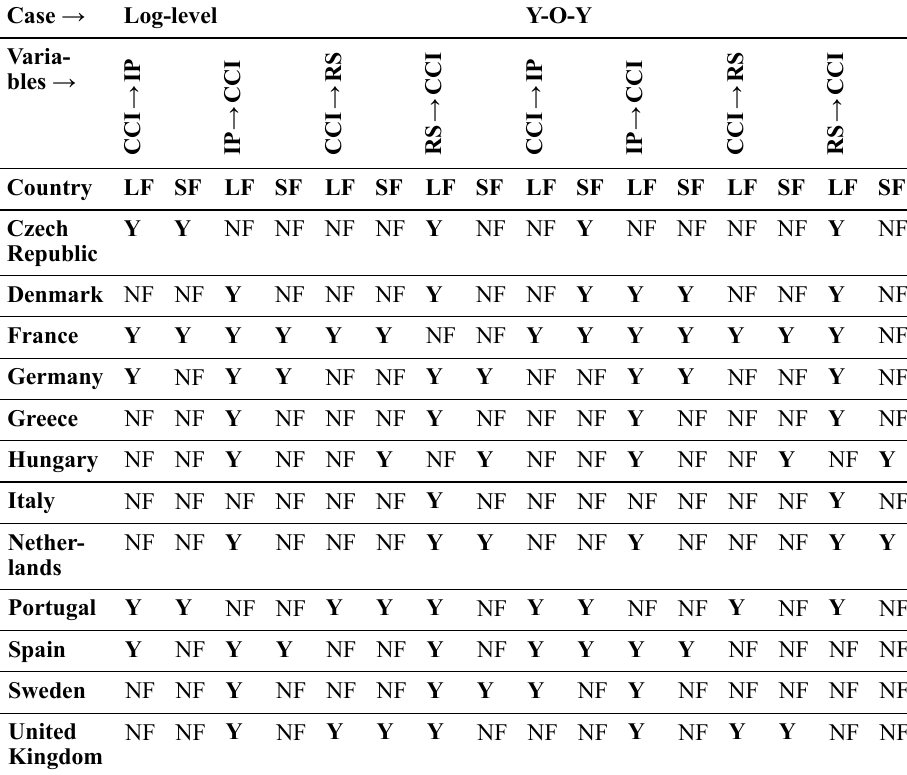
Table 5. Granger causality in frequency domain for all